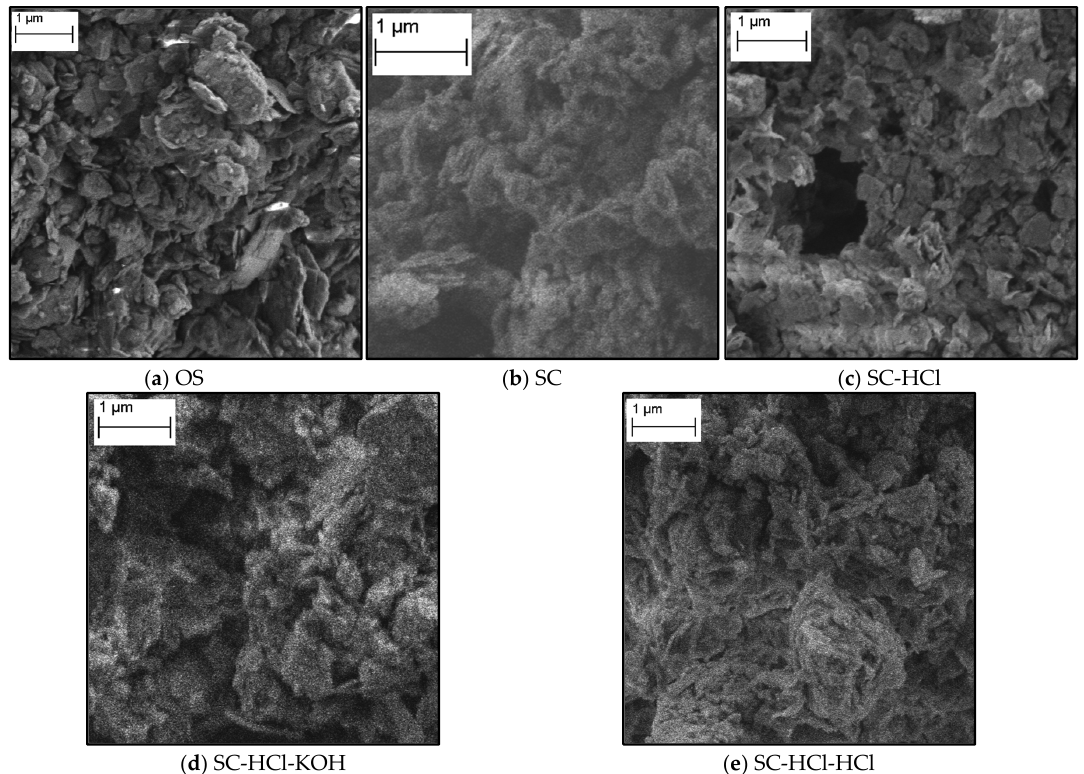
Figure 3. SEM images of oil shale samples at 10,000 magnification to illustrate increasing chemical treatment on development of porosity and loss of crystalline “structured” components (scale bar indicates 1 μm). Energies 2018 , 11 , x FOR PEER REVIEW